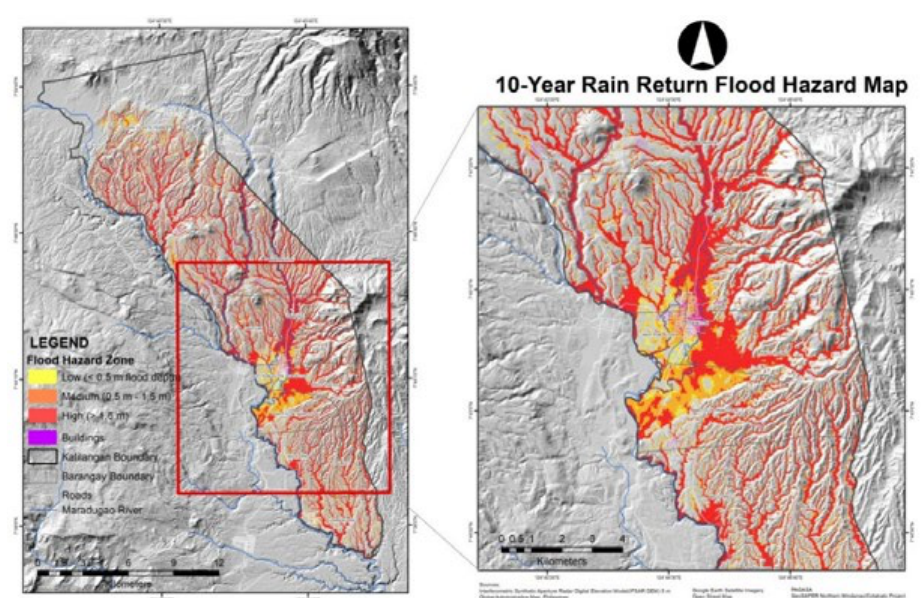
Fig. 5: Flood hazard map of 10-year return period